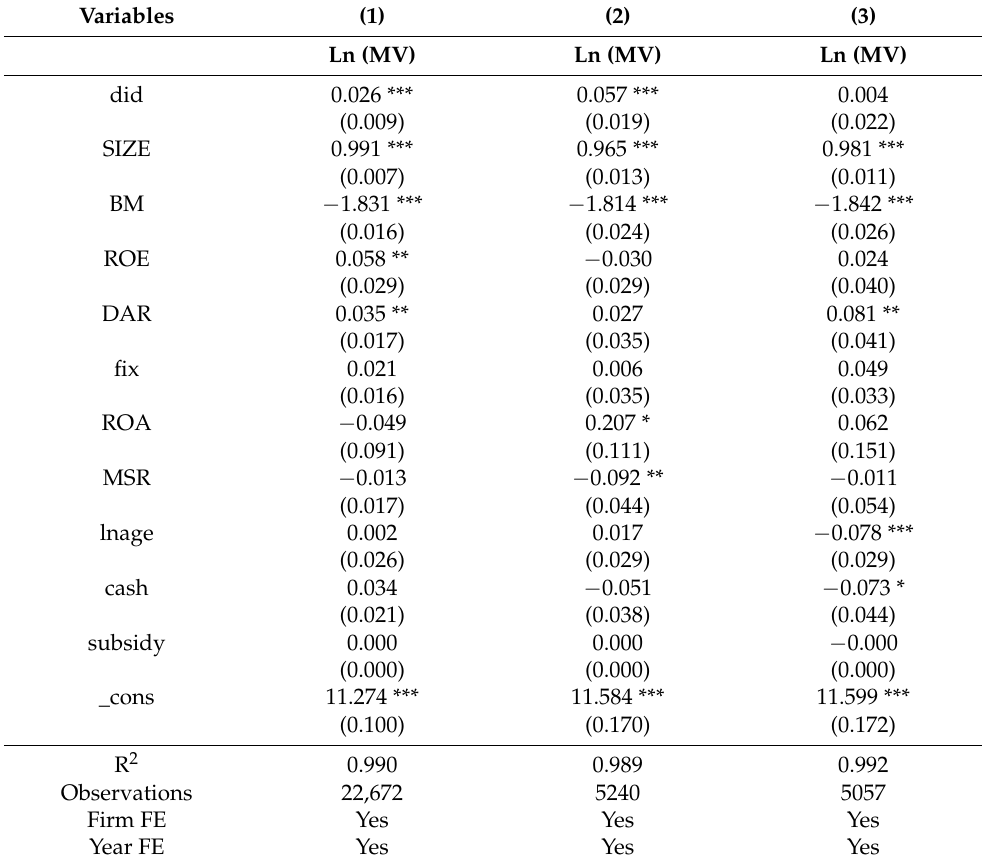
Table 10. Heterogeneous analysis of the different